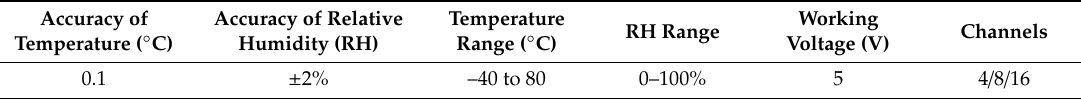
Figure 7. Temperature and relative humidity sensor: ( a ) monitoring probe and ( b ) probe embedded in concrete. Table 5. Relevant parameters of temperature and relative humidity